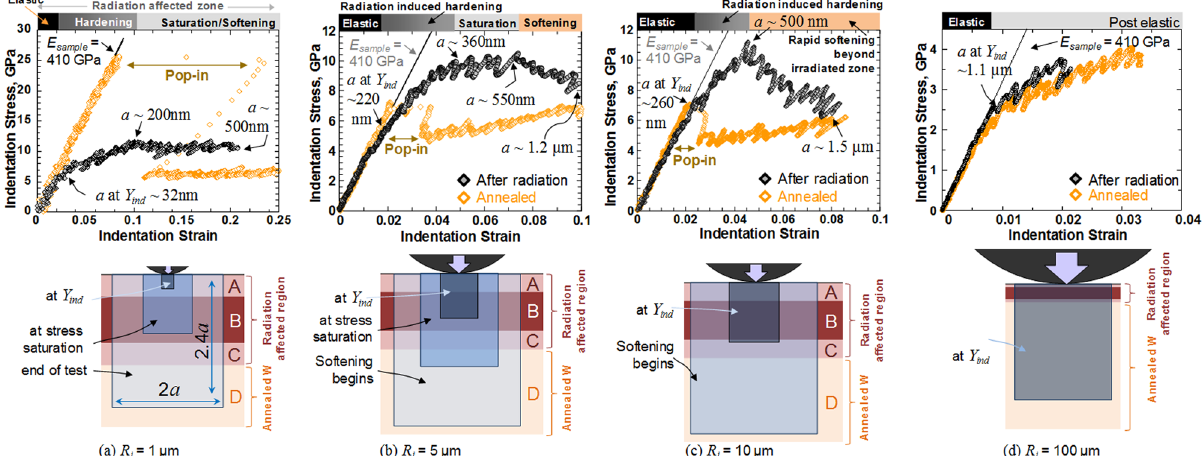
Figure 4. Comparing the indentation stress-strain responses between annealed (orange curve) and irradiated (black curve) W grains of near (001) orientation for four different indenter tip radii ( a ) 1 µ m, ( b ) 5 µ m, ( c ) 10 µ m and ( d ) 100 µ